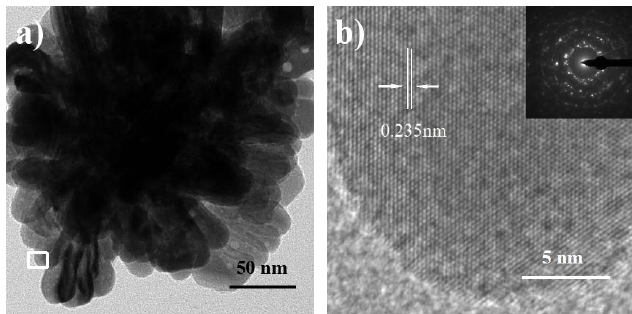
Figure 2. Transmission electron microscopy (TEM) ( a ) and high resolution TEM (HRTEM) ( b ) images of the ball-like Ag nanorod aggregates. Inset in ( b ) is the selected area electron diffraction (SEAD) pattern of Ag nanorod